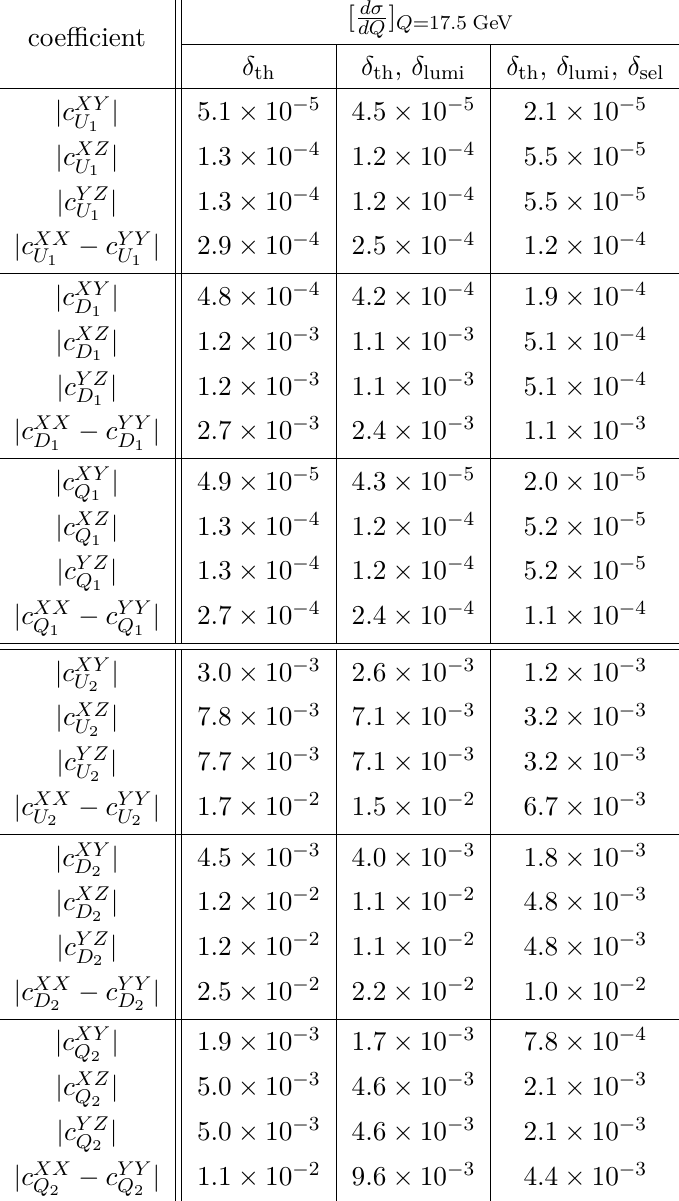
Table 2 . Expected best constraints on the time-dependent coefficients in the ( c U for Q = 17 . 5 GeV . The part of the experimental uncertainties that are assumed to be 100% correlated between binned data is indicated in the column